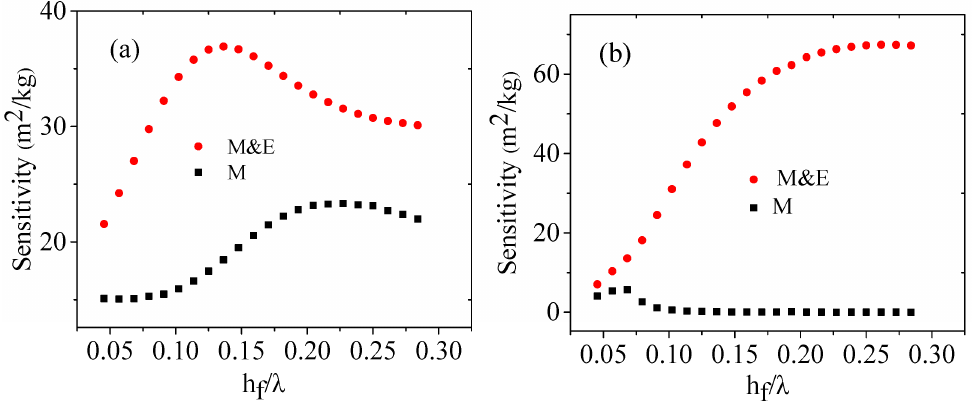
Figure 6. Sensitivities of humidity sensors induced by mass loading (M) and mass loading & conductivity variation (M & E) for: ( a ) Rayleigh wave; ( b ) Love wave.